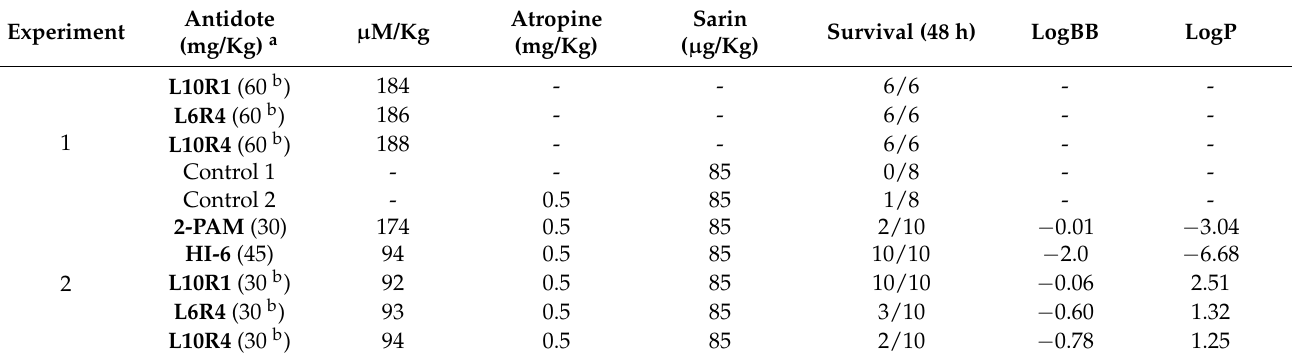
Table 2. Effects of 2-PAM , HI-6 and non-oxime reactivators on sarin poisoned